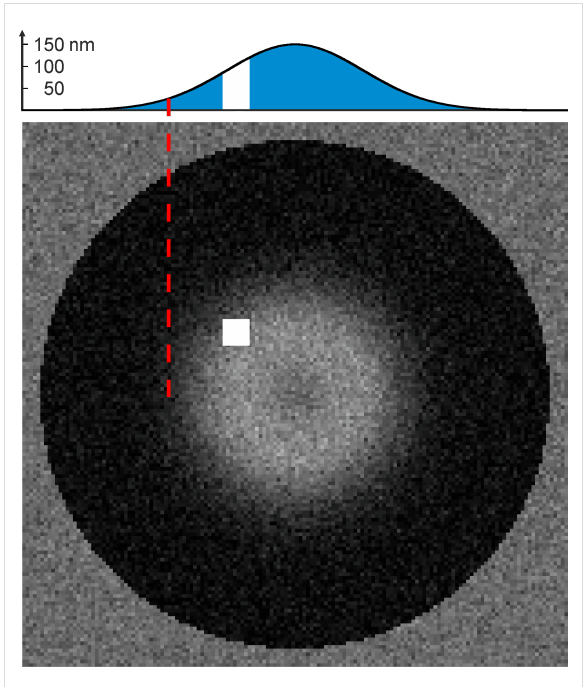
Figure 6: Simulated image of an individual MSAMS partially detached from a glass substrate submerged in water, for which the gap filled with liquid water was, for simplicity, chosen Gaussian-like with a maximum separation of 150 nm in the middle of the contact (see graph at top of the simulated image). The simulation parameters are given in Table 1. Note that around the maximum separation in the middle of the contact the lower greyscale values (darker region) indicate a first order interference minimum (zero order minimum corresponds to intimate contact) similar to what is observed in Figure 5A1. The red dashed line indicates separation of about 25 nm. Due to the noise level even in the simulation it is not possible to reliably distinguish between contact and non-contact region for a separation below 25 nm. The white square has been calculated assuming the gap being filled with air instead of